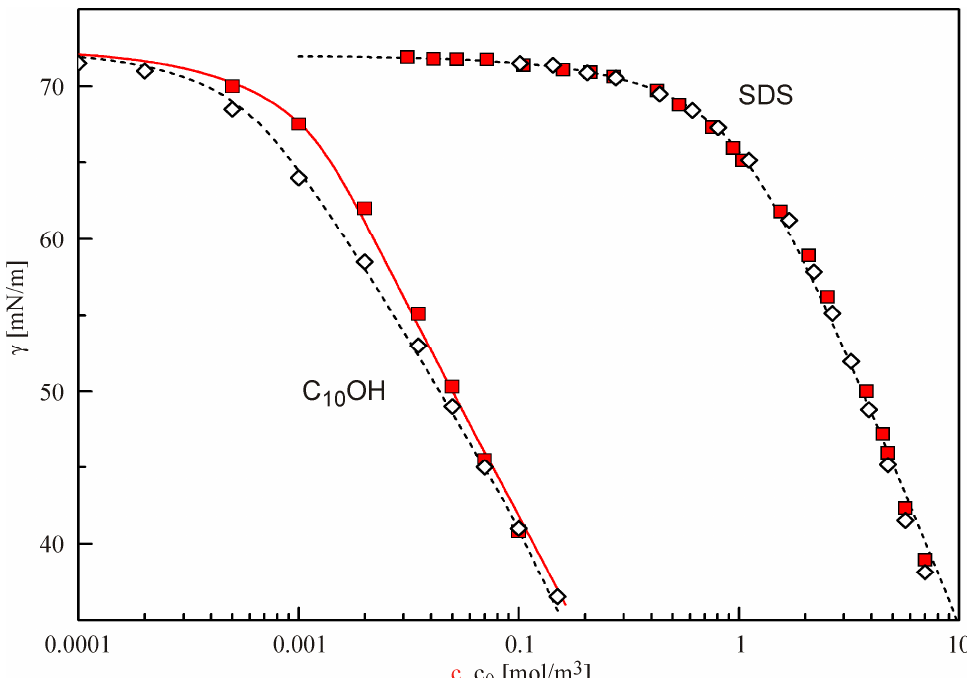
Figure 3. Equilibrium surface tension isotherms for aqueous solutions of C 10 OH and SDS, respectively, as measured by drop profile ( ) and bubble profile ( ) analysis tensiometry; curves are calculated isotherms; for details see text.